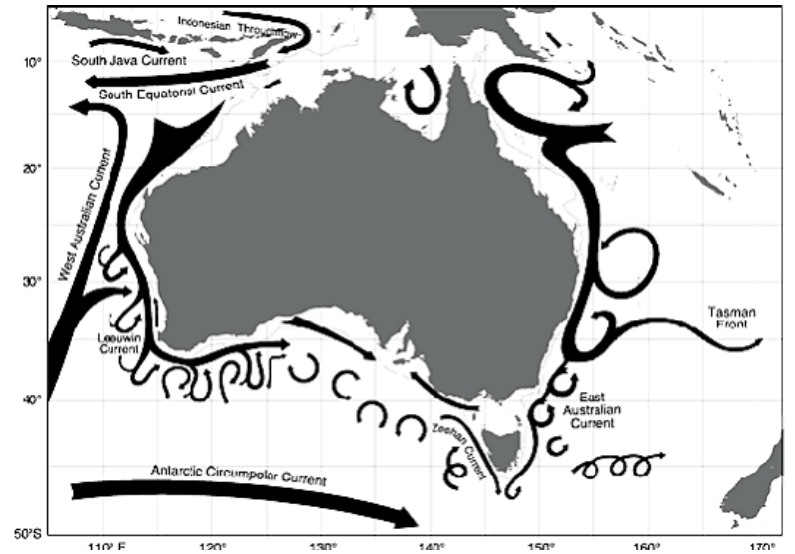
Figure 1 – boundary currents around Australia